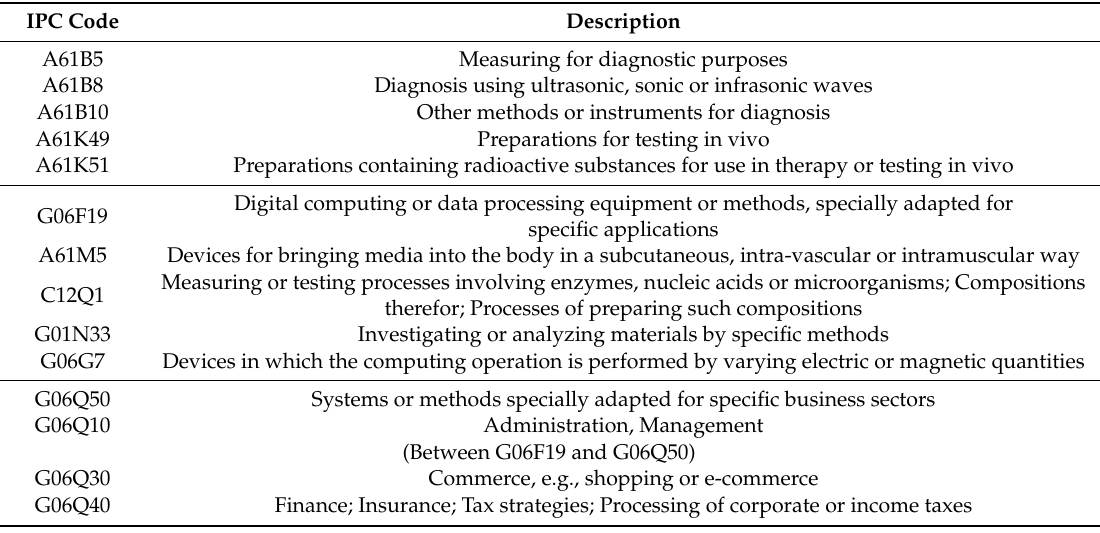
Table A6. Description of IPC codes for the science-based innovation period